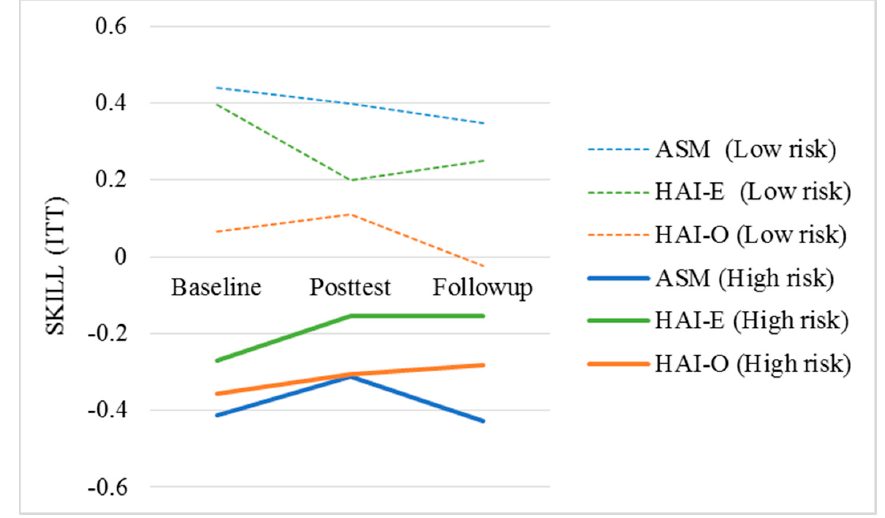
Figure 4. Trajectory of SKILL composite scores by treatment condition and risk status. ASM: Academic Stress Management; HAI-E: Human–Animal Interaction Enhanced; HAI-O: Human-Animal Interaction only; ITT: Intention-to-treat